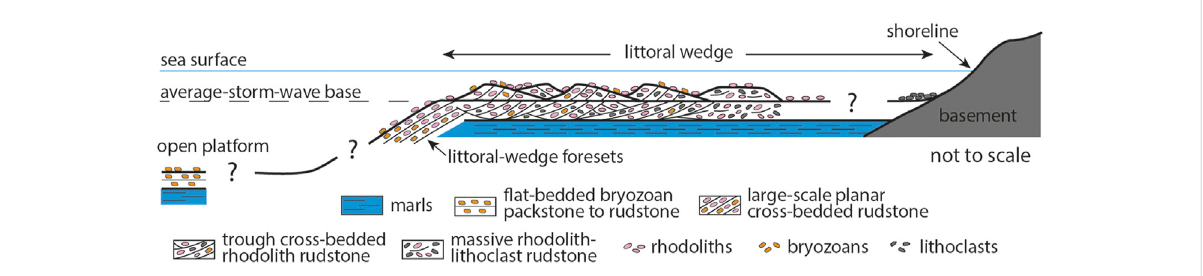
FIGURE 8 Depositional model for the Acinipo limestone. Rhodoliths grew on a littoral wedge atthe western side of theRuinas de Acinipo bay. The wedge was affected by storms that incorporated the rhodoliths, other bioclasts, and lithoclasts from the basement into submarine dunes. Rhodoliths were brokenbutcontinuedtogrowonthedunes.Rhodolithsandbioclasticgravelweresweptfromthewedgetopandaccumulatedontheforesetsofthe littoral wedge. Bryozoans dominate bioclasts in the distal portion of the foresets and in the open-platform